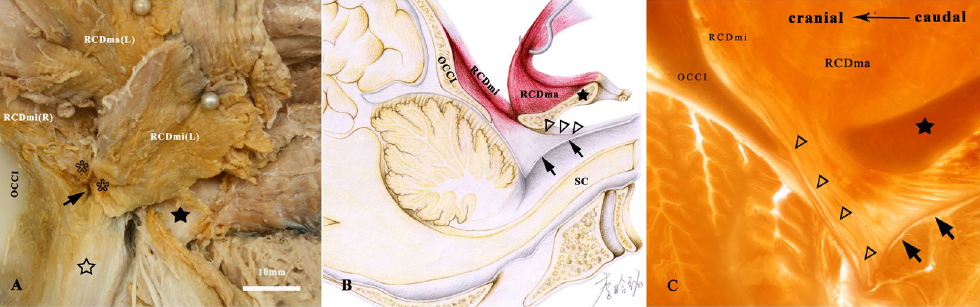
Figure 5. The RCDmi entered the epidural space through the posterior atlanto-occipital interspace and inserted into the spinal dura mater in Indoasian finless porpoise . ( A ) Gross dissection specimen of the post- occitiptal region. ( B ) Diagram of the connection of the RCDmi with the dura mater. ( C ) P45 plastinated sheets (median sagittal section) showing the connections between the RCDmi and the spinal dura mater. The muscular bundles ( * ) of the ventral end of the RCDmi pierced into the posterior atlanto-occipital interspace ( ↑ ) and then continued with the tendon-like fibers ( Δ ) and finally inserted into the dura mater ( ↑↑ ). ☆ : The capsule of atlanto-occipital joint. OCCI: occipital bone. SC: spinal cord. RCDmi: the rectus capitis dorsal minor. RCDma: the rectus capitis dorsal major. RCDmi (R): the rectus capitis dorsal minor in right side maintained in situ . RCDmi (L): the rectus capitis dorsal minor in left side was reflected from the occipital bone. RCDma (L): the rectus capitis dorsal major in left side was reflected from the occipital bone. ★ : The fused spinous process. Han-Ming Li at Dalian Medical University was appreciated for her drawing the diagram of Indoasian finless porpoise (Fig. 5B).